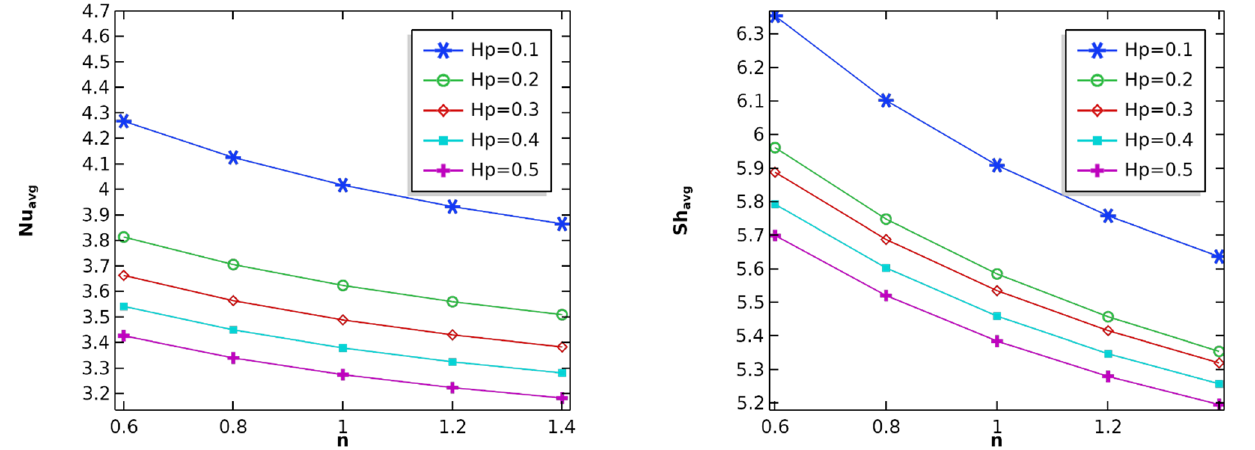
17 of 20 Figure 14. Variation in local Nu and Sh . Table 7. Average Nu and Sh comparison. Le = 1